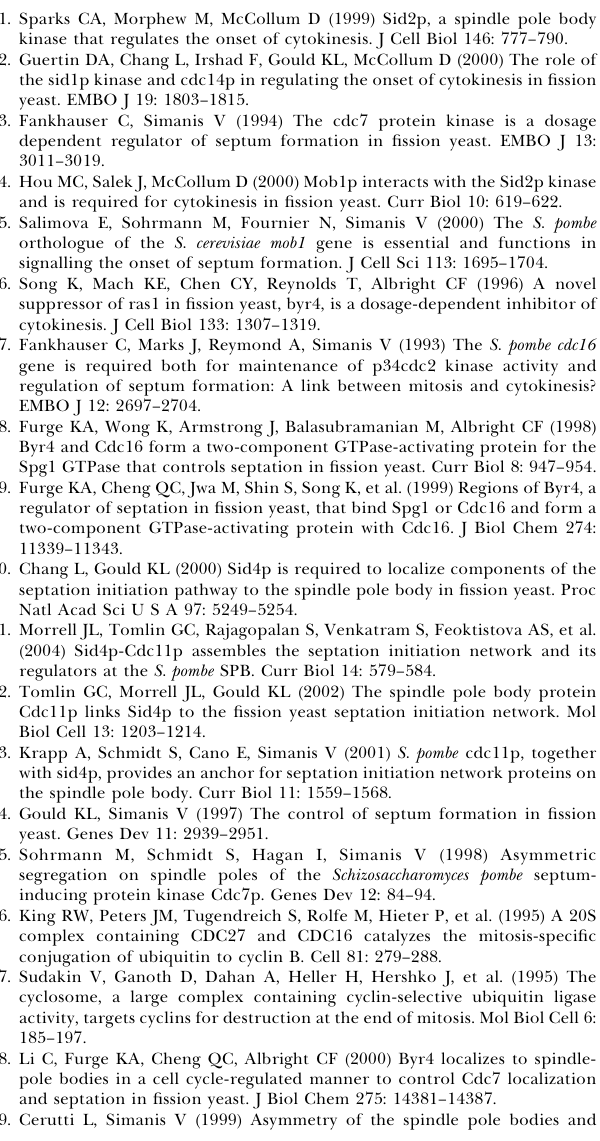
Figure S1. Analysis of Septation in Other APC/C Mutants, cut9 -665 and lid1 -6, and Overexpression of Slp1p (A) Cells were first synchronized at metaphase using cold sensitive allele of b -tubulin, nda3 -KM311. The cultures were shifted to 36 8 C to release cells from the metaphase block and to inactivate Cut9p and Lid1p functions. Cells were then collected after 1 to 2 h release from the metaphase block and scored for septation phenotype (normal versus excessive septum) by staining the cells with DAPI and aniline blue. (B) The APC/C activator Slp1p was overexpressed from